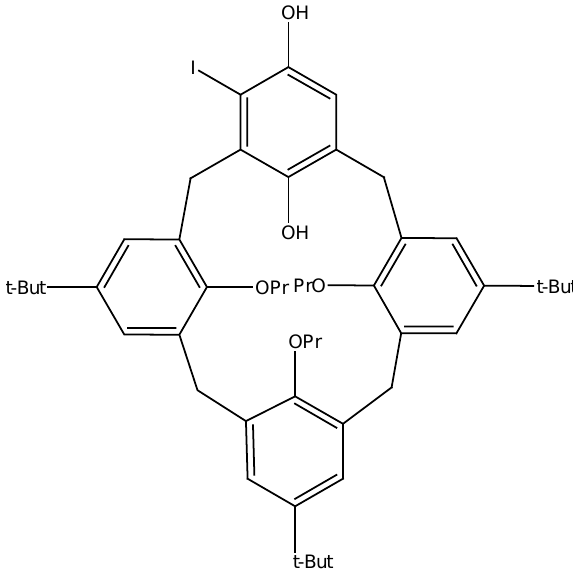
Figure 21. 25,27-dihydroxy-26,28-bis[5-(4-methyl-6-hydroxypurimidine)thiaamyloxy] calix[4]arene. 4.1.3. Calixarene-Based Lanthanide and Actinide Ion Selective